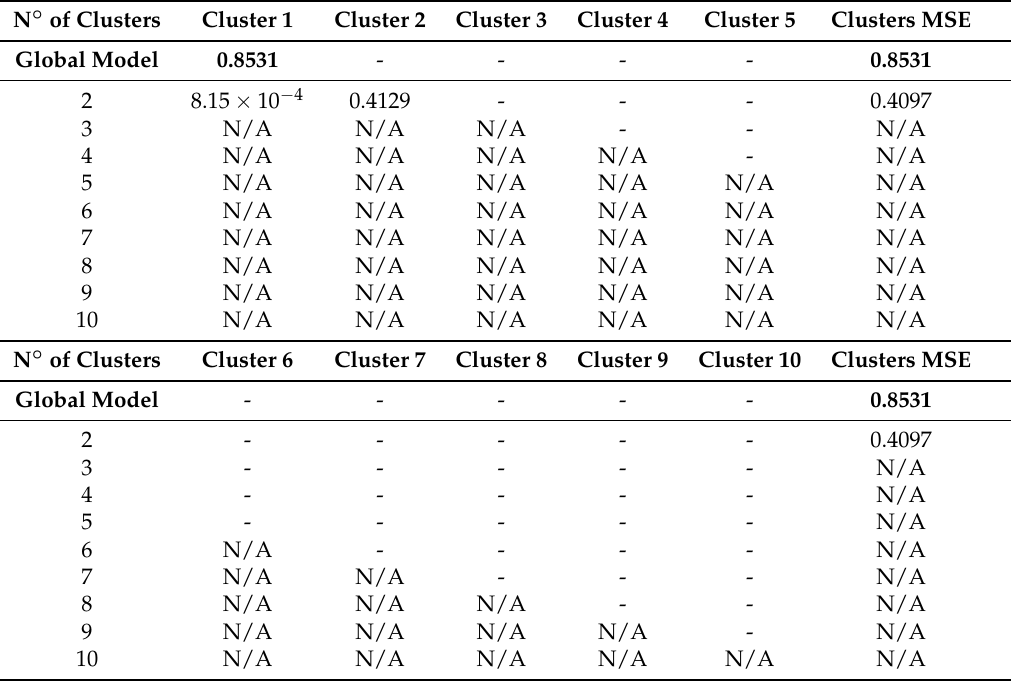
Table 2. Clusters mean squared error (MSE).